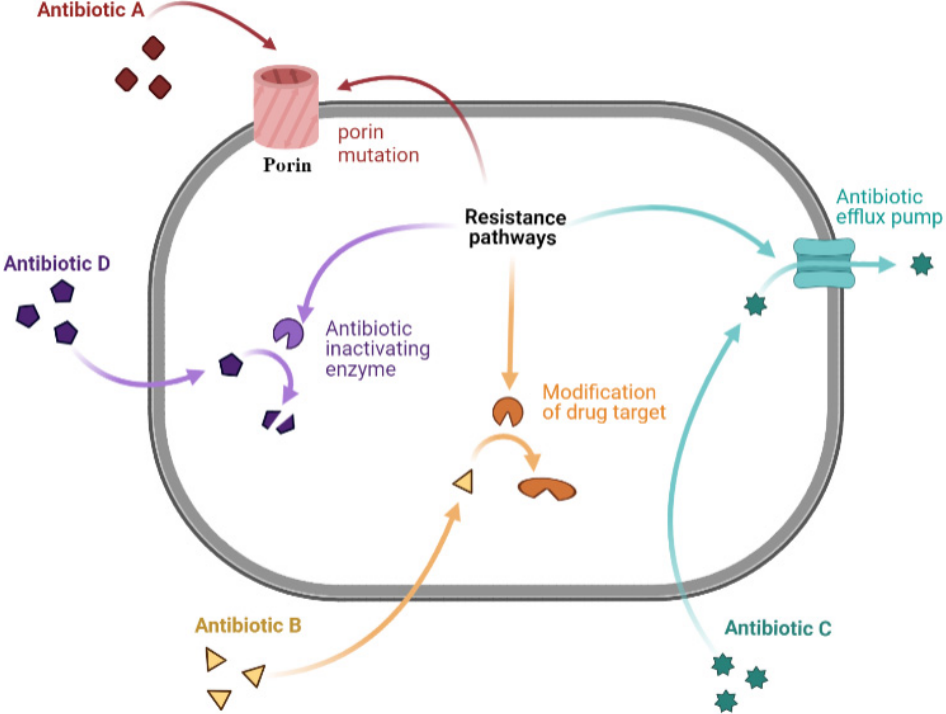
Figure 1. Representation of a bacterial cell, illustrating the common mechanisms of antibacterial resistance. Antibiotic A corresponds to the mechanism of limiting drug uptake; B to the modification of drug target; C to antibiotic efflux; and D to drug inactivation by bacterial enzymes. Figure was prepared using Biorender.com. (accessed on 20 January 2022)